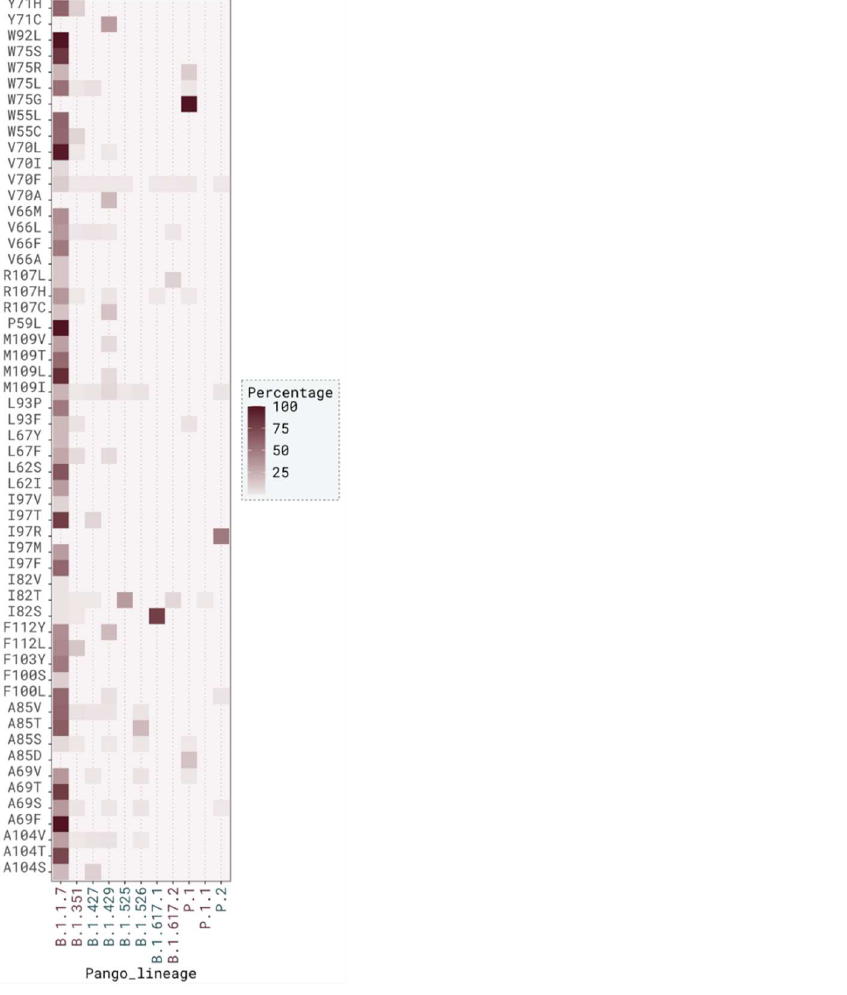
Figure 7. Distribution across VOC (garnet) and VOI (teal) of SARS-CoV-2 M protein sequences.